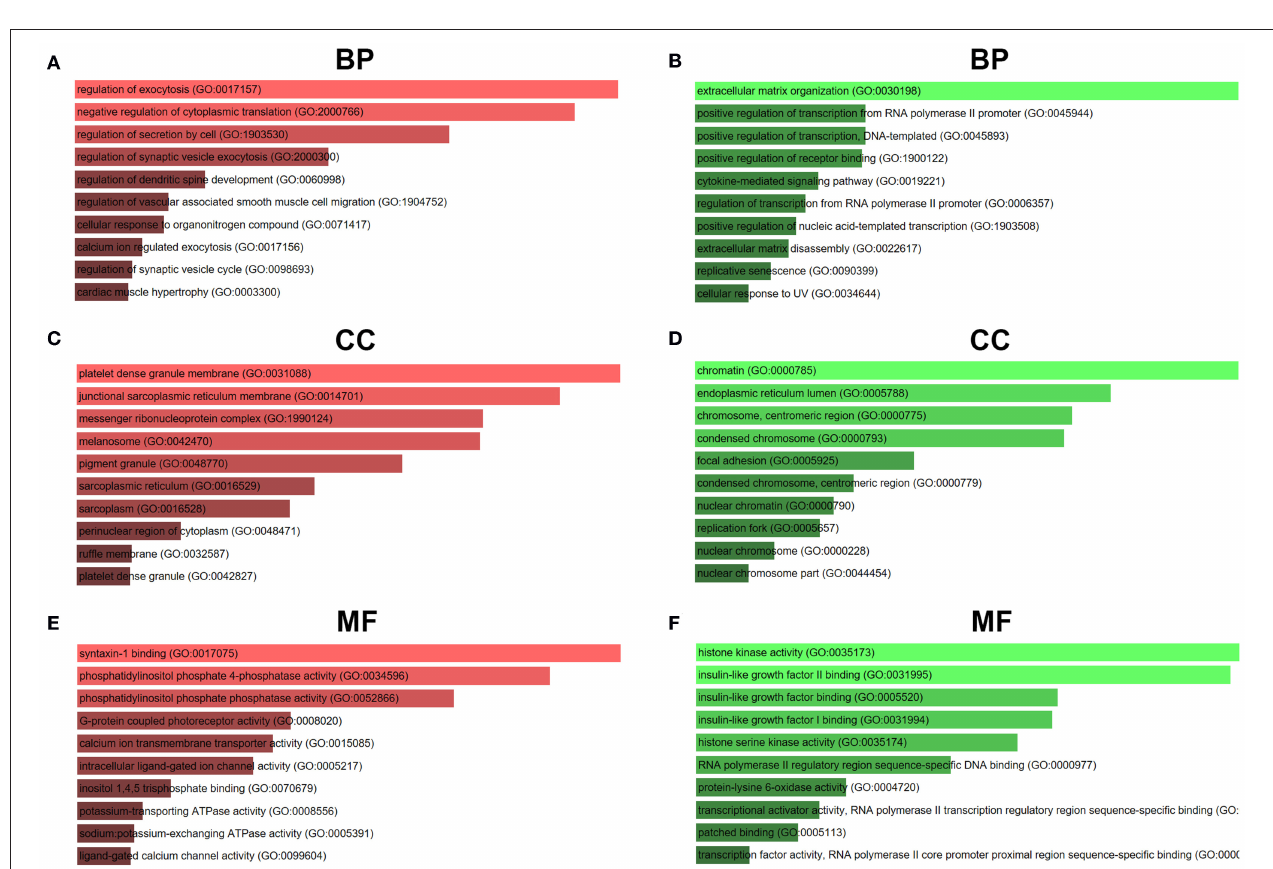
FIGURE 7 | GO functional annotation of candidate genes. (A) The top 10 enriched BP items of downregulated candidate genes; (B) the top 10 enriched BP items of upregulated candidate genes; (C) the top 10 enriched CC items of downregulated candidate genes; (D) the top 10 enriched CC items of upregulated candidate genes; (E) the top 10 enriched MF items of downregulated candidate genes; (F) the top 10 enriched MF items of upregulated candidate genes.